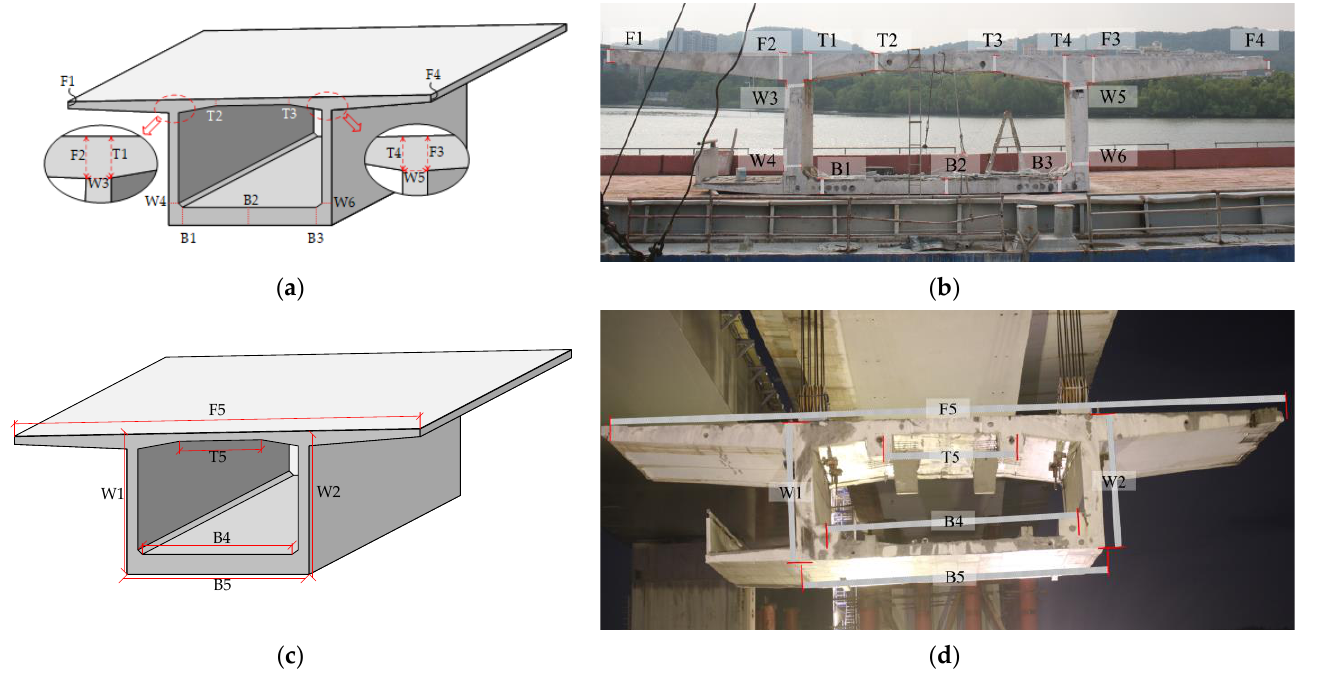
Figure 8. Cross-sectional measurement position layout. ( a ) Layout of thickness measurement position, ( b ) schematic of thickness measurement position on site, ( c ) layout of outline measurement position, ( d ) schematic of outline measurement position.